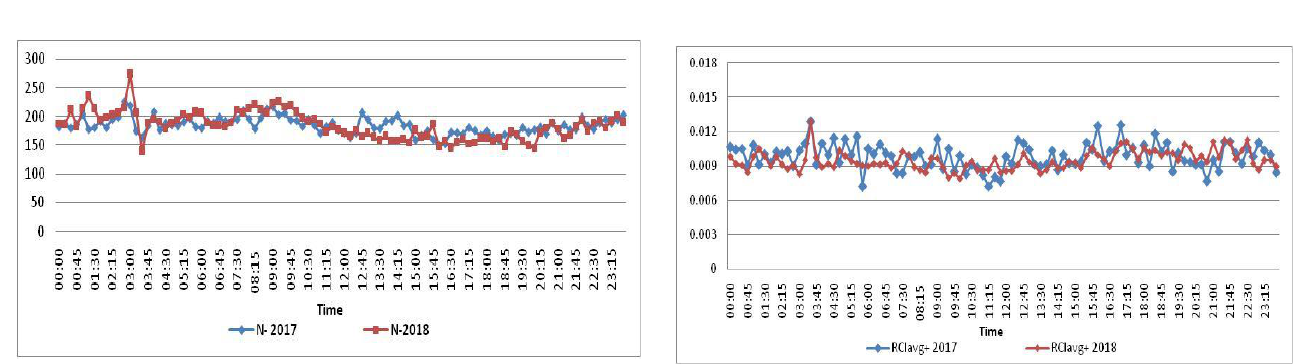
Figure 7. Comparison between numbers of downward power ramps in 15 min interval at each observation time t for the years 2017 and 2018.